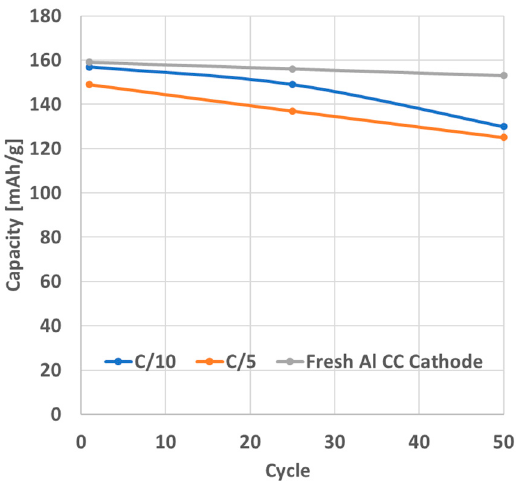
Figure 12. Discharge of cathode half-cells with C-rates of ( a ) C/5, and ( b ) C/10.